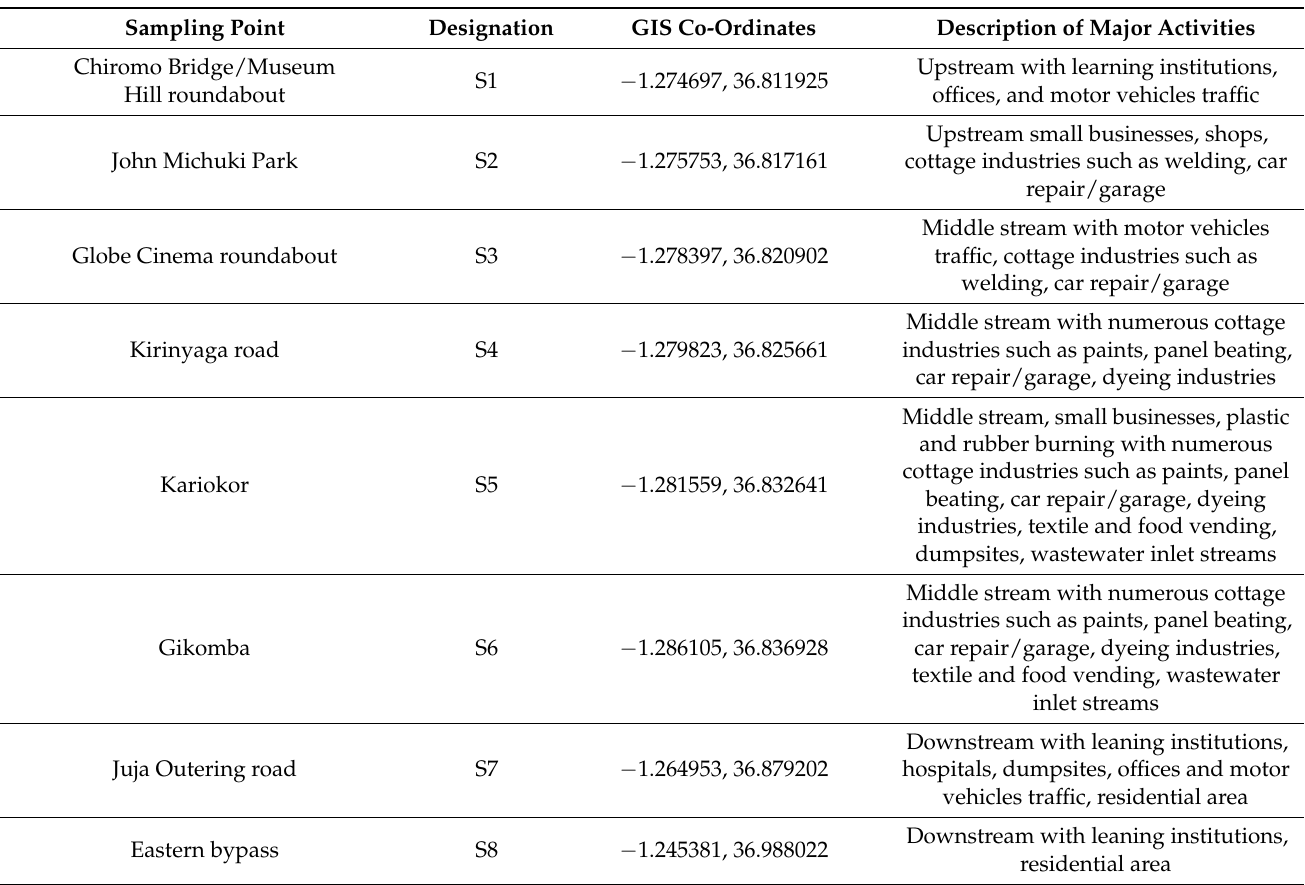
Table 1. Sampling point, geographic coordinate system, and description of the major anthro- pogenic